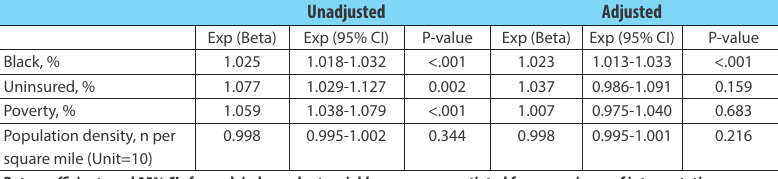
Table 2. Results for unadjusted and adjusted linear regression models with log-transformed COVID-19 case rate as the dependent variable